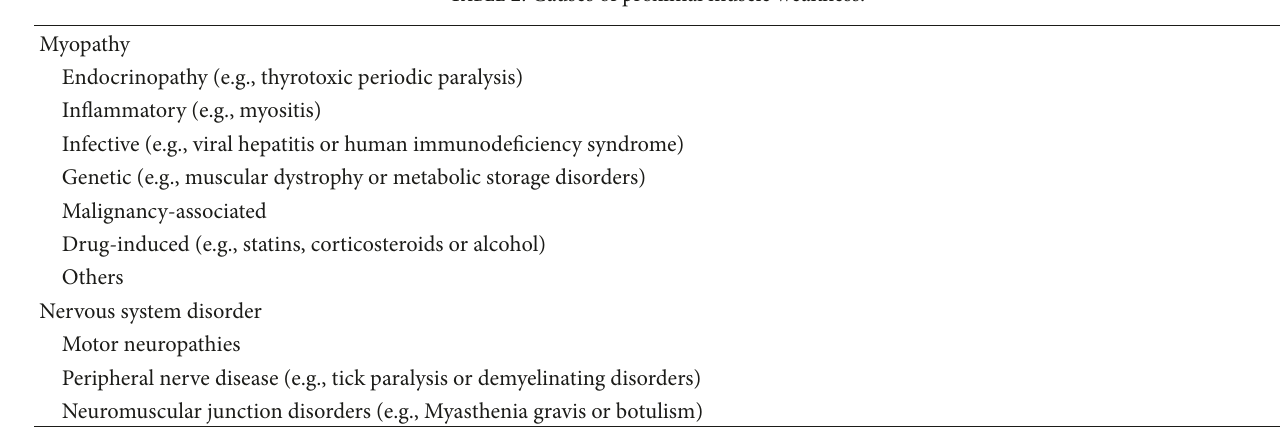
Table 2: Causes of proximal muscle